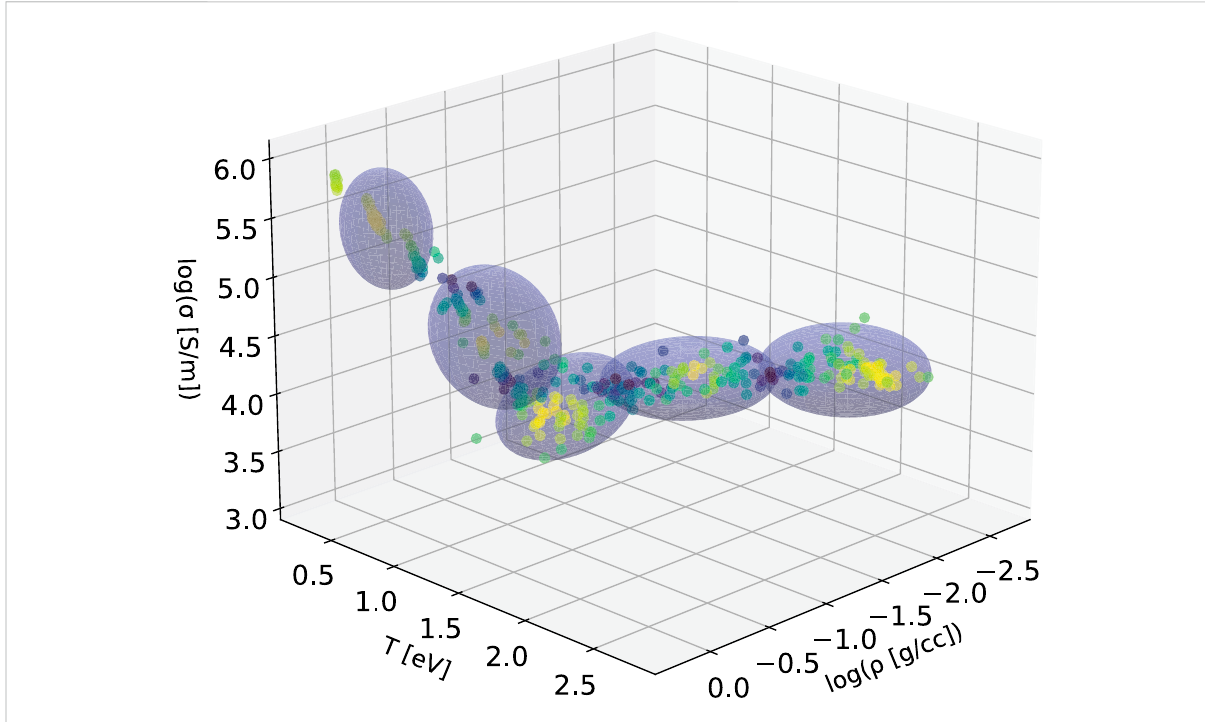
FIGURE 8 Electrical conductivity versus density for the MLM and DK data. Shown are two temperatures, 10kK (blue) and 30 kK (green), for Cu. (To get a sense of the trend in the data, a small band of temperatures around 10kK and 30kK was